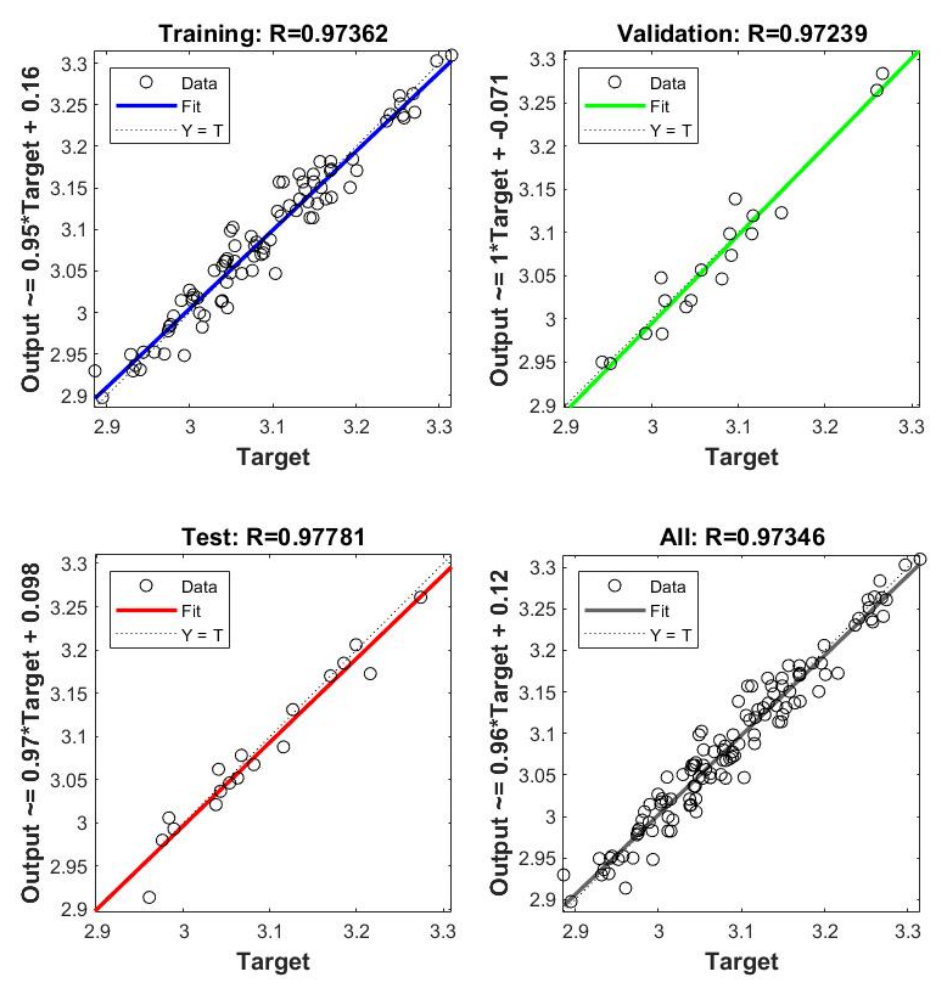
Figure 17. Overall performance of the proposed ANN model (N5-5-2).